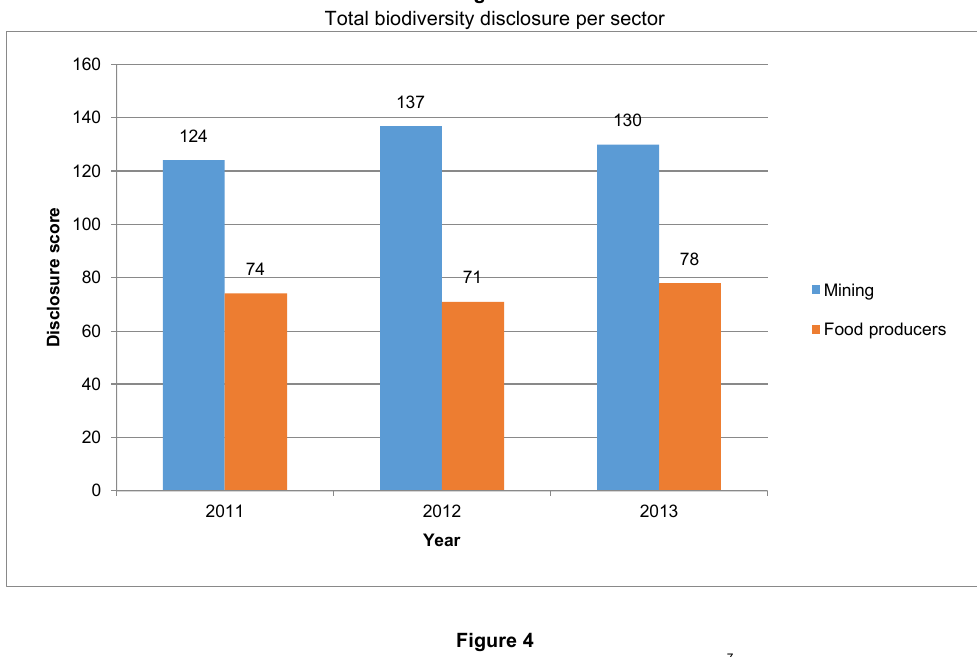
Disclosure score comparison: Mining and food sector